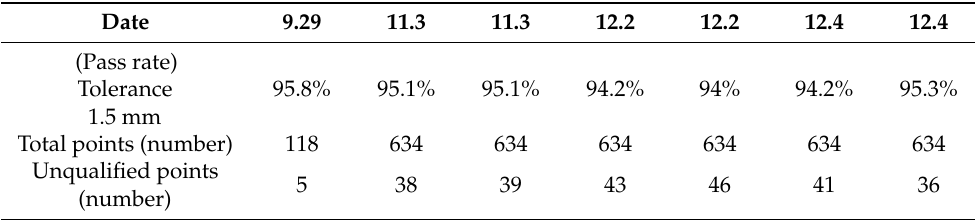
Table 4. Window point analysis